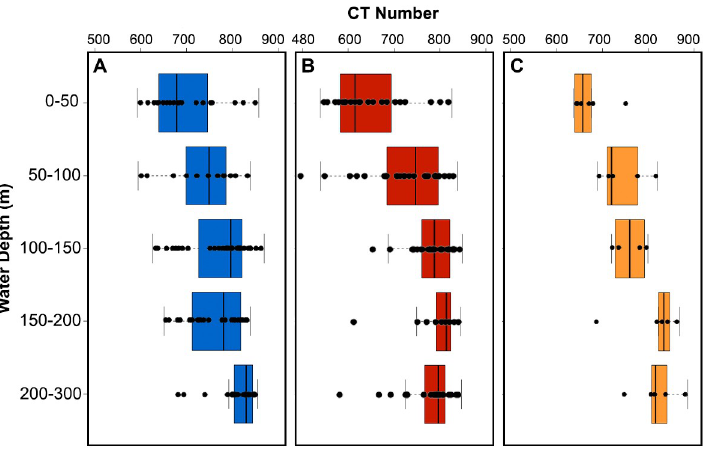
Fig 2. Box-and-whisker plot of shell density with water depth for A) Neogloboquadrina pachyderma (n = 120), B) Turborotalita quinqueloba (n = 115) and c) Limacina helicina (n = 25) sampled from the crater area in 2016. Boxes extend from the lower to upper quartile values of the data, with a line at the median. Whiskers indicate 1.5 times the inter-quartile distance. Black dots are single